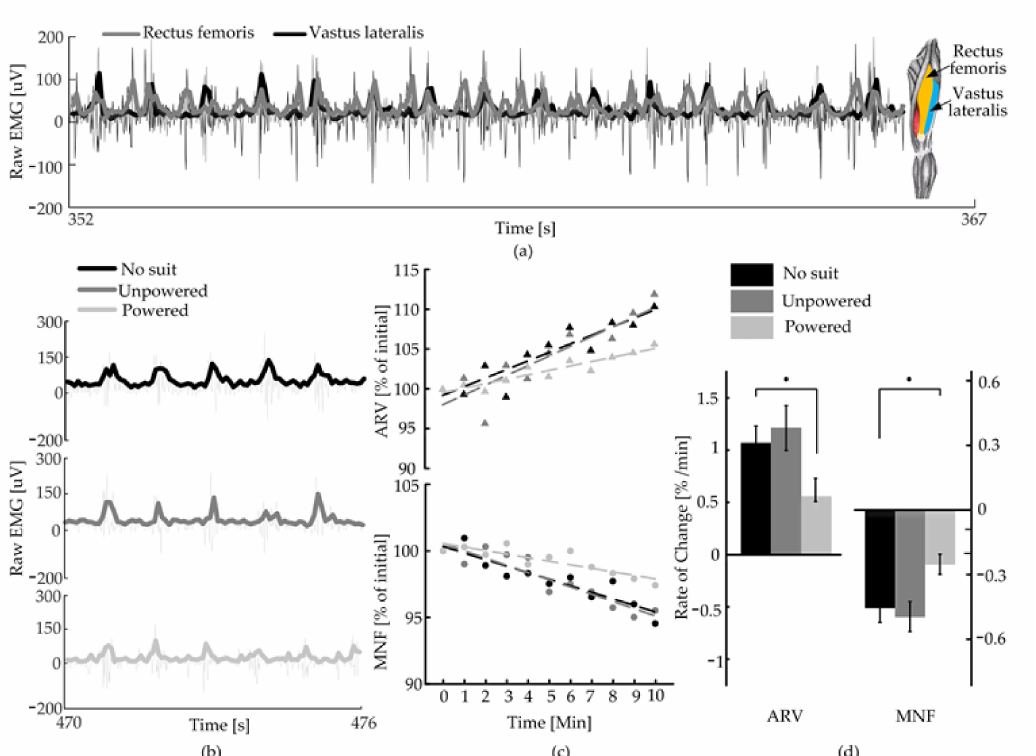
Figure 10. Fatigue analysis. ( a ) Raw signal and envelope of EMG of the rectus femoris and vastus lateralis of one subject at a normal speed ( v = 1.25 m/s). ( b ) Raw signal and envelope of EMG of the vastus lateralis in the conditions of No-Suit, Unpowered and Powered. ( c ) Trend of the average rectified value (ARV) and median frequency (MNF) of the EMG signal of one subject in the 10 min of tests. Indexes are expressed in percentage of their initial value. ( d ) Slope of ARV and MNF. Both indexes confirm that wearing the H-Suit significantly reduces the onset of fatigue ( p = 0.03 for ARV and p = 0.01 for the MNF). Error bars show the standard error of the